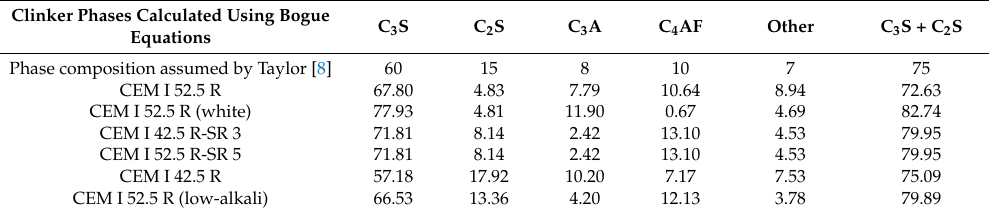
Table 2. Clinker phases calculated using Bogue equations [12], and the theoretical phase composition assumed by Taylor [8], expressed as a